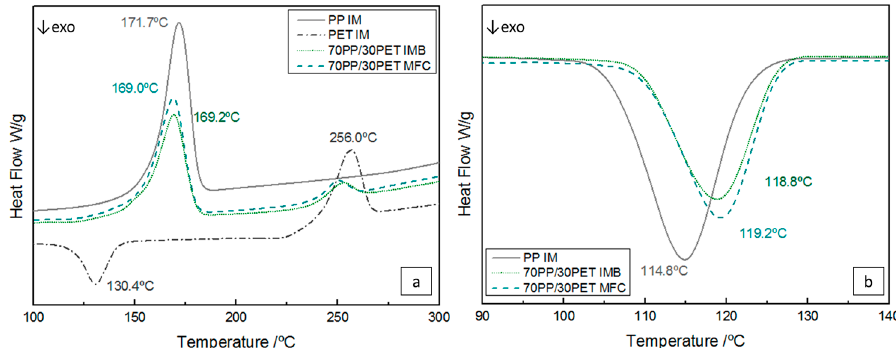
Figure 4. DSC thermograms of PP IM, PET IM, 70PP/30PET IMB, and 70PP/30PET MFC during ( a ) heating; and ( b ) cooling.